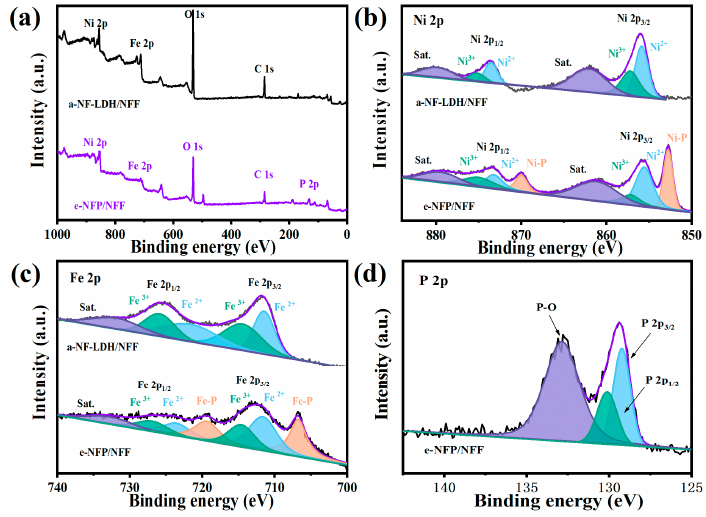
Figure 5. XPS analysis: ( a ) XPS survey spectra of a-NF-LDH/NFF and e-NFP/NFF; and high-resolution spectra of ( b ) Ni 2p, ( c ) Fe 2p, and ( d ) P 2p.